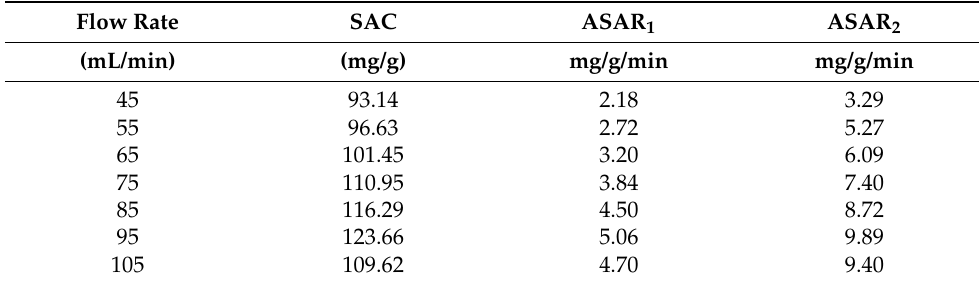
Figure 4. Variation of ( a ) SAR and ( b ) ASAR as a function of flow rate (NaCl 0.4 M, 1.2 V). Table 2. Comparison of SAC and two types of ASAR calculated for various flow rates (NaCl 0.4 M, 1.2 V).